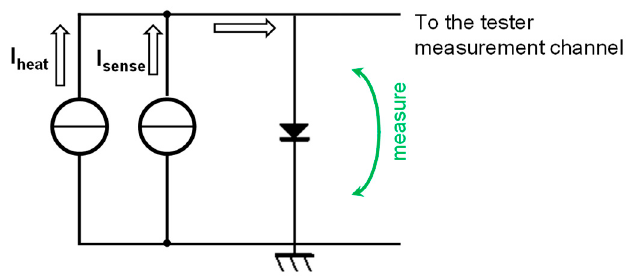
Figure 1. Scheme for the thermal transient measurement of a diode.